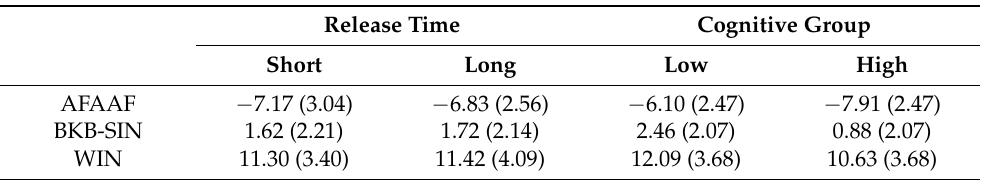
Table 3. Mean SNR50 (dB) for the two RTs and the two cognitive performance groups. Values enclosed in parentheses represent one standard deviation (N = 29).